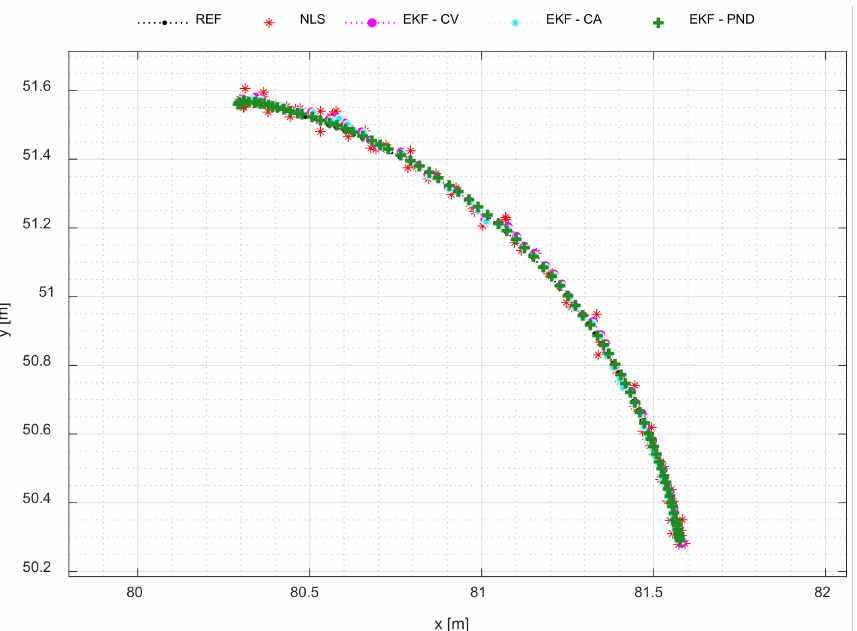
Figure 12. Comparison of antenna positions estimated with NLS, EKF-CV, EKF-CA, and